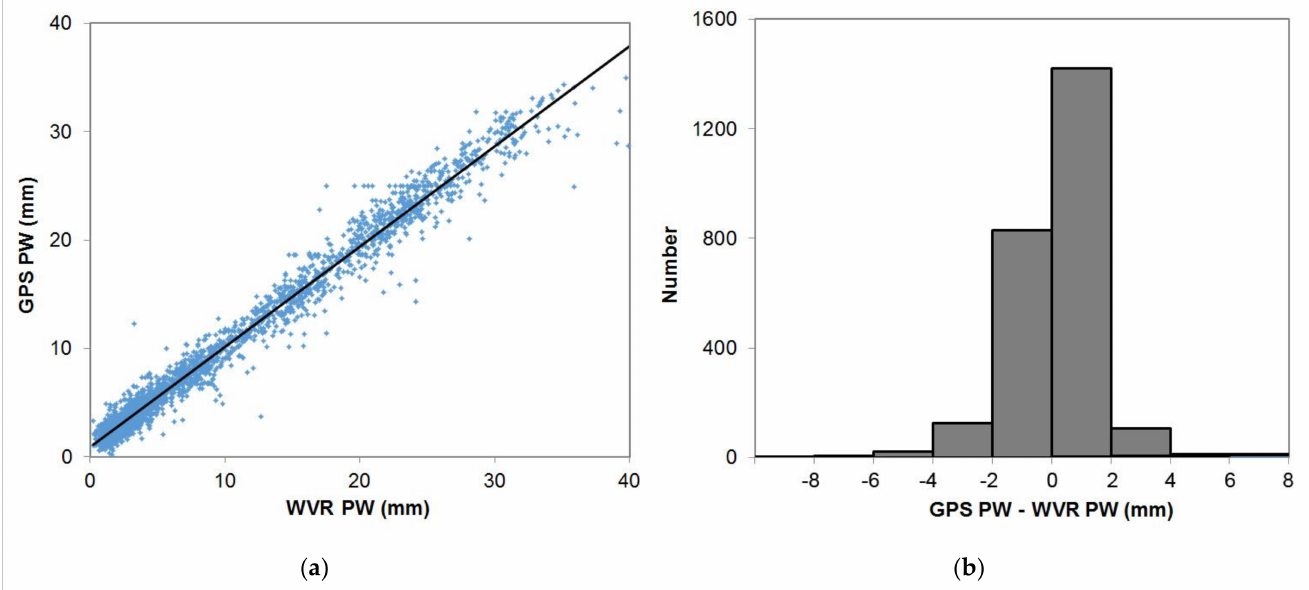
Figure 5. ( a ) Scatter plot of the total moisture content PW according to GPS observations and measurements of WVR; ( b ) histogram of the difference between GPS PW and WVR